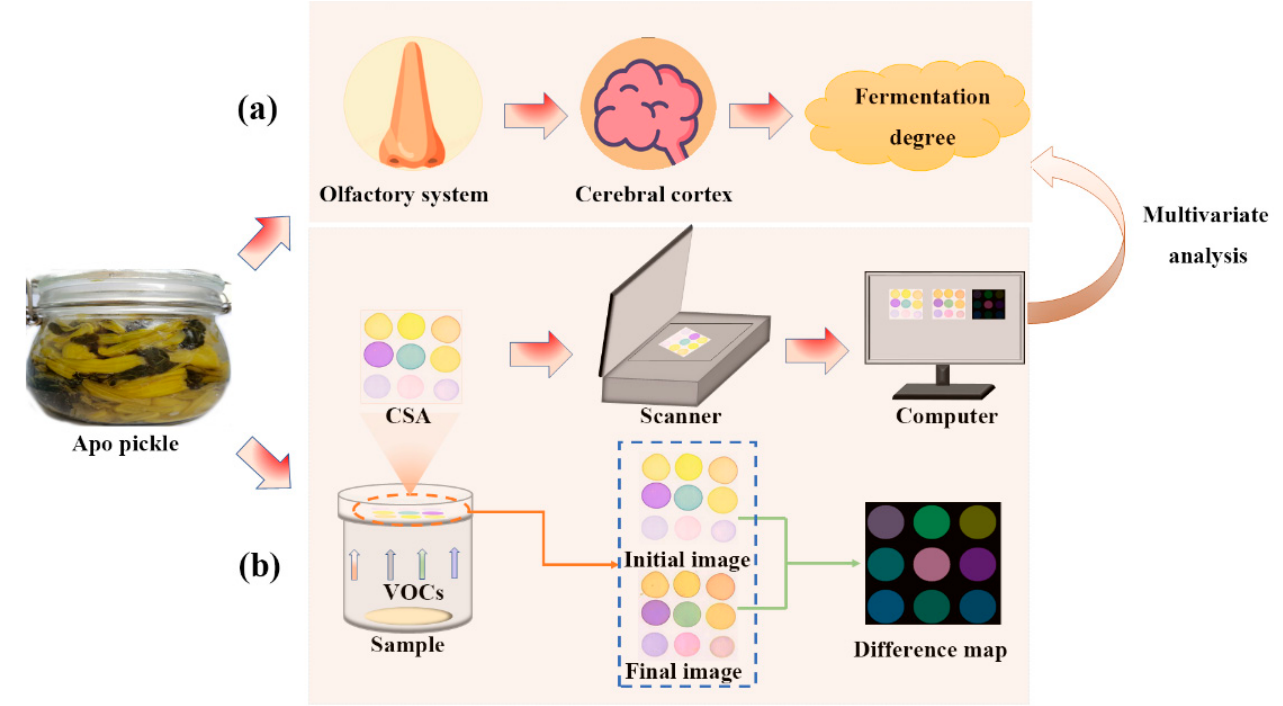
Figure 1. Schematic diagram of the colorimetric sensors array (CSA). ( a ) Determination of fermentation degree by the olfactory system; ( b ) determination of fermentation status by using CSA.